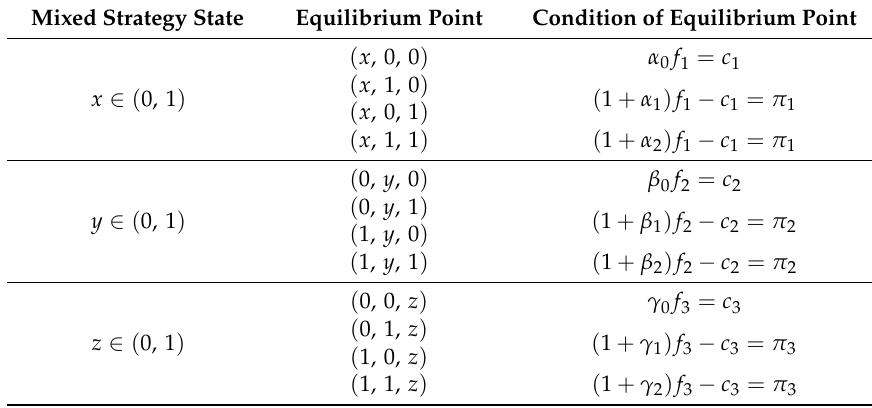
Table 2. The conditions of equilibrium point for two groups adopting pure strategy Mixed Strategy State Equilibrium Point Condition of Equilibrium